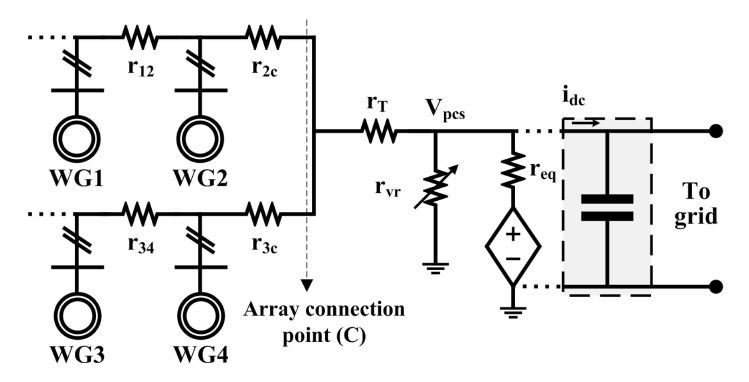
Figure 5. Schematic map of DC section in the proposed system.